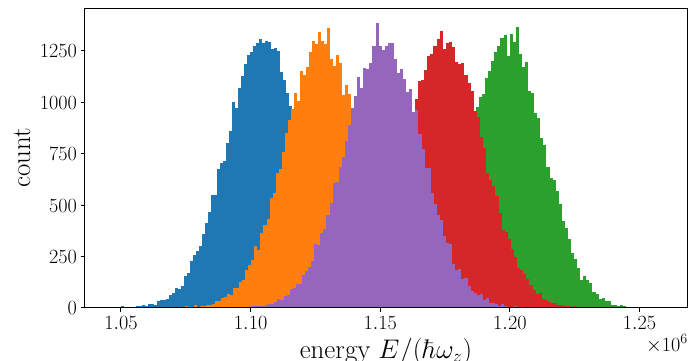
Figure 6: Histograms of the distribution of energies of sets of states generated with the FSS method. The sets represent N = 10 4 atoms in a 3D harmonic trap with aspect ratio λ = 4 at temperatures, from left (blue) to right (green), ) = k T / ( ħ h ω z B